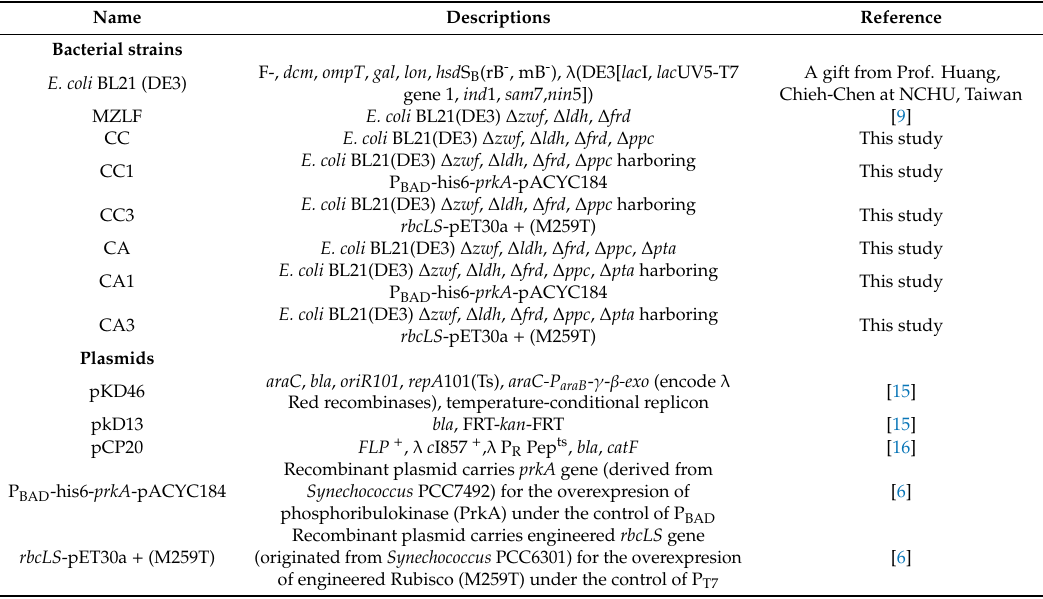
Table 1. The list of bacterial strains and